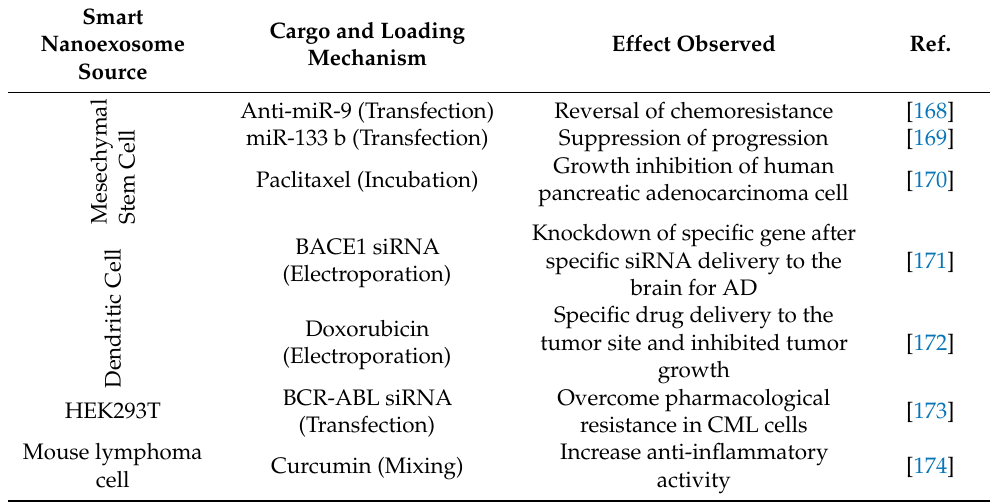
Table 2. Smart nanoexosome therapeutics, such as the sources, cargoes and loading mechanisms as well as the observed effects for smart